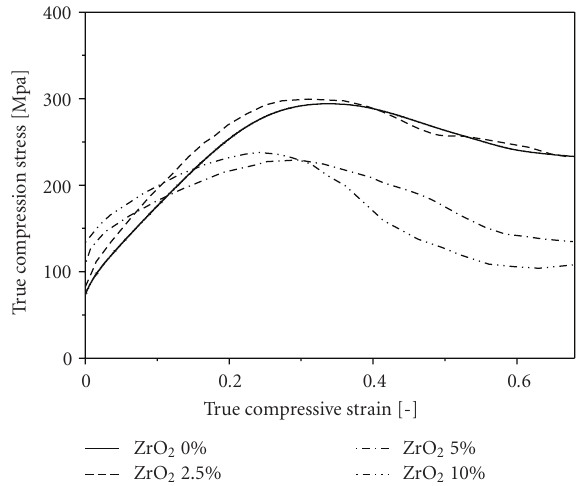
Figure 2: True compression stress as a function of plastic com- pressive strain of the TRIP-steel/Mg-PSZ honeycomb samples with respect to di ff erent zirconia